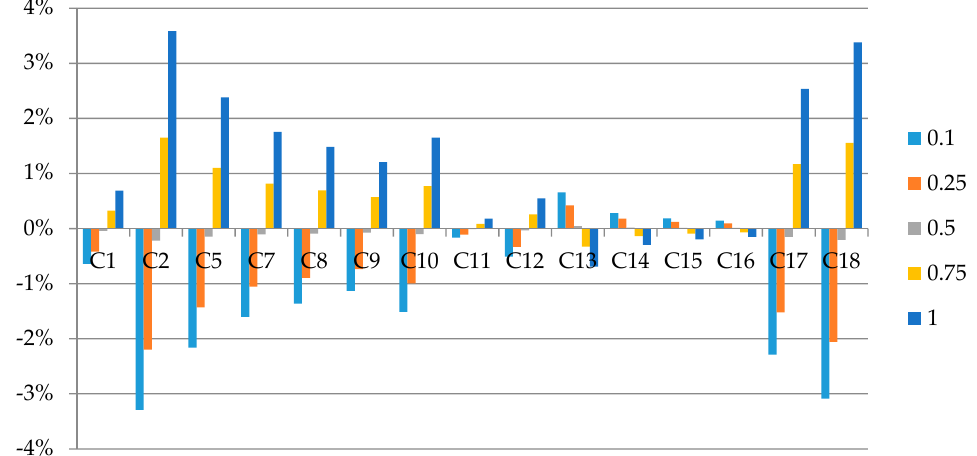
Figure 8. The e ff ect of the factor “promotion Figure 8. The effect of the factor “promotion information”.